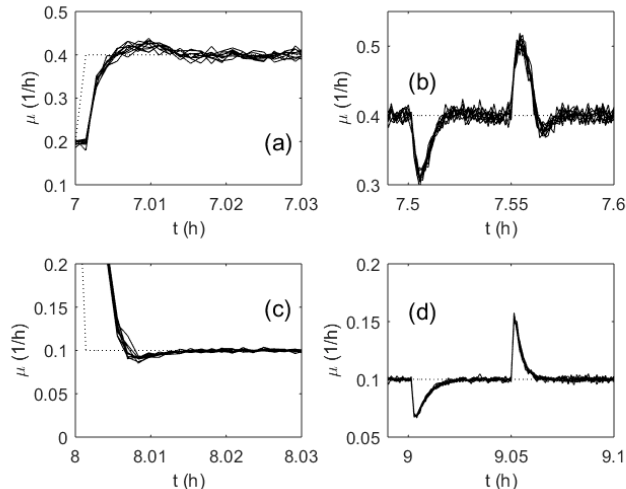
Figure 12. Transient processes of the specific growth rate in a series of 10 test runs (randomly initialized ANN weights): Setpoint change ( a ) and ( c ); disturbance rejection ( b ) and ( d ); the setpoint (dotted line); ANN-based control (solid line).